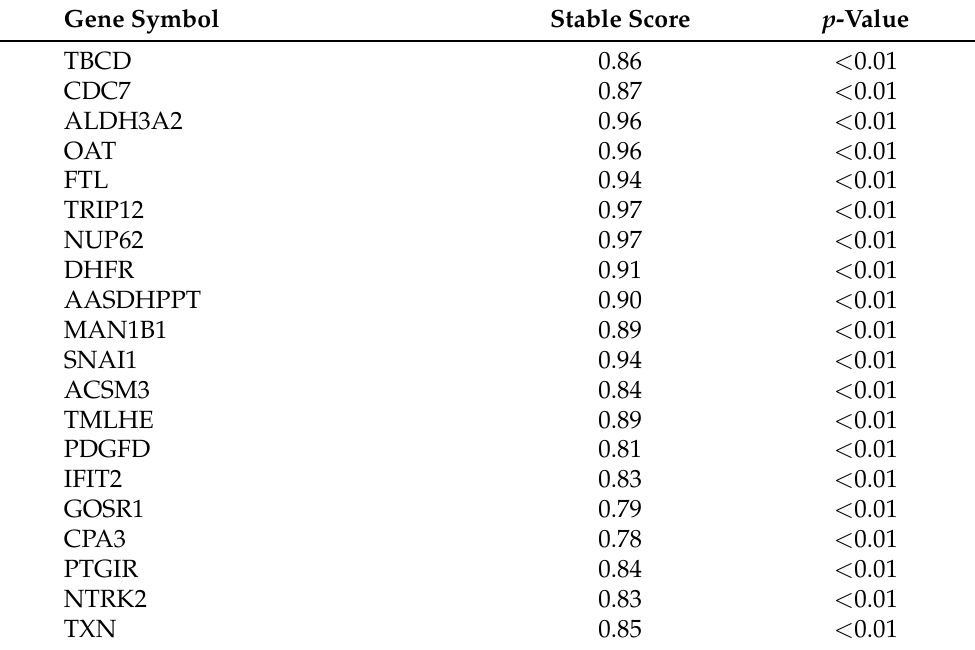
Table 4. The top-20 genes found in the CESC (cervical carcinoma cancer) dataset. Gene Symbol